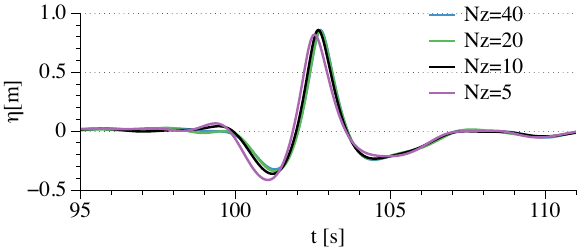
Figure 2. The grid convergence study of the vertical grid resolution in a σ -coordinate arrangement for the focusing wave group generated using a wave packet method.